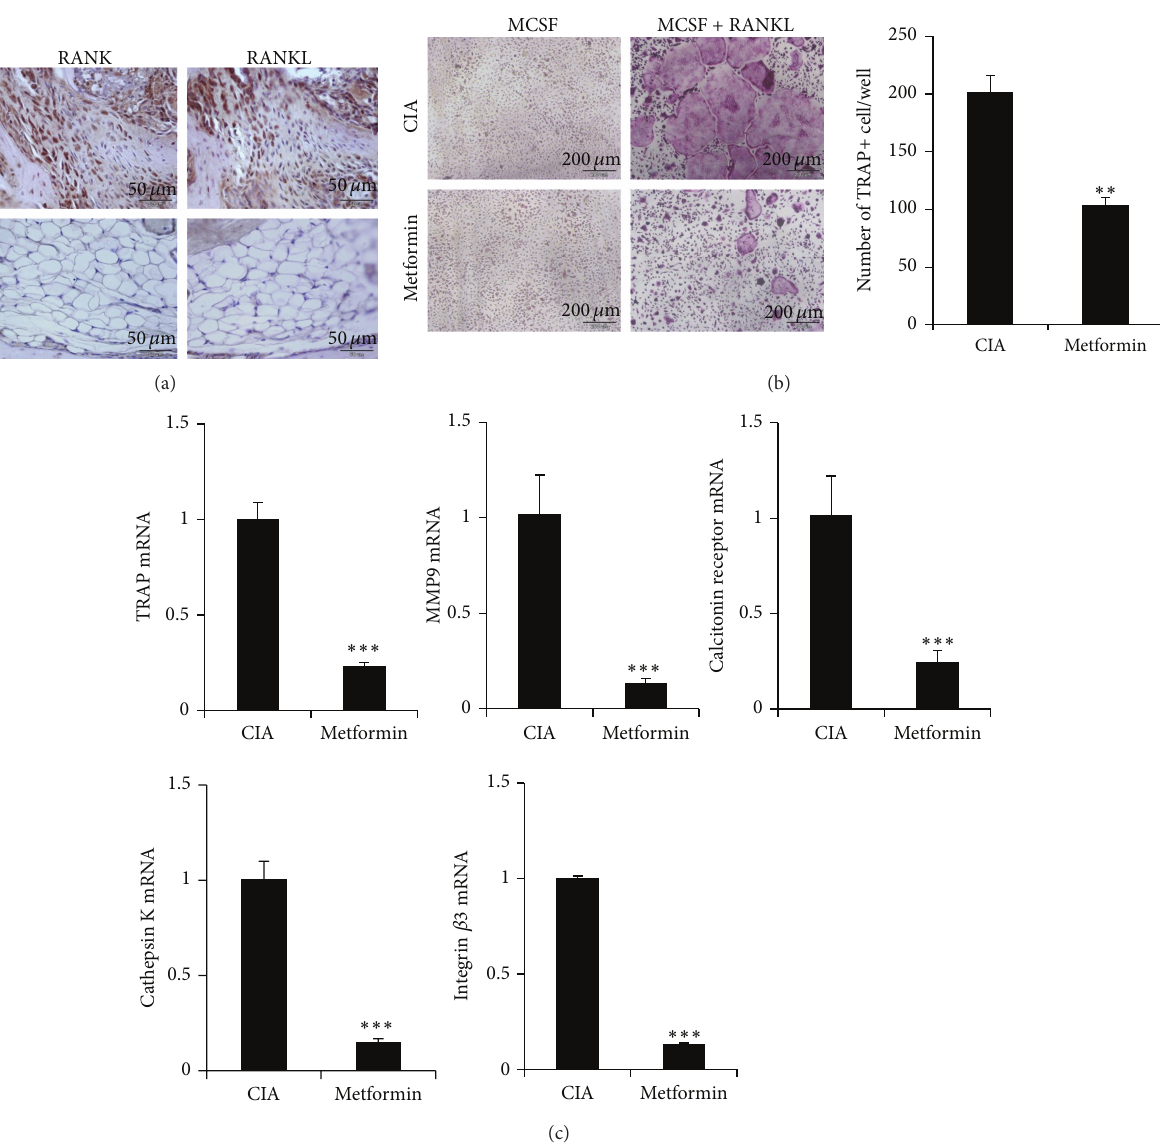
Figure 4: Metformin inhibits osteoclast formation in CIA mice. (a) Joint tissues of CIA control mice ( 𝑛 = 5 ) and metformin-treated CIA ( 𝑛 = 5 ) were stained with anti-RANKL and anti-RANK antibodies 70 days after the first immunization. All images were obtained for each mouse ( 𝑛 = 5 ), showing representative images (scale bar = 50 𝜇 m). (b) Isolated preosteoclasts from each group were cultured with 10ng/mL M-CSF and/or 50ng/mL RANK. Differentiated osteoclasts were stained with TRAP. The TRAP+ cells were indicated in graph (right) (scale bar = 200 𝜇 m). (c) The mRNA expressions of TRAP, MMP-9, calcitonin receptor, cathepsin K, and integrin 𝛽 3 as osteoclast markers were quantified by real-time PCR. Data are presented as the mean ± SD of four independent experiments ( ∗ 𝑃 < 0.05 ; ∗∗ 𝑃 < 0.01 ; ∗∗∗ 𝑃 < 0.005